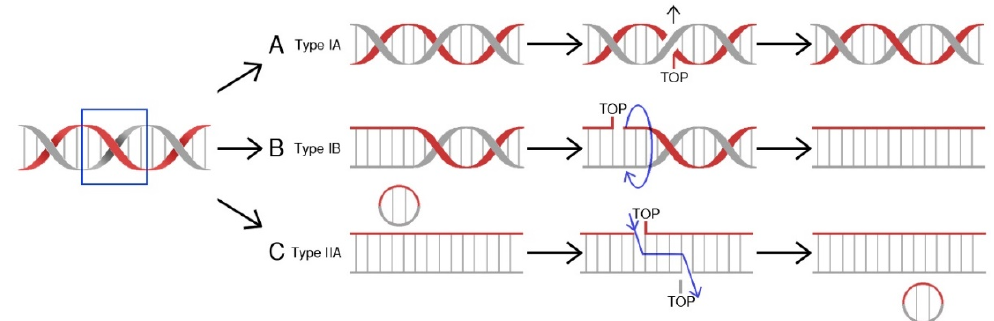
Figure 1. Mechanisms of action for human topoisomerases. ( A ) Topoisomerase IA binds to DNA at a particular binding site, and then claves one strand, forming a transient 5 ′‐ phosphotyrosyl bond. The other DNA strand is transferred through the resultant break, allowing DNA to relax. Religation ends the process. ( B ) Toposiomerase IB works in a controlled rotation mechanism and in contrast to type IA enzymes forms a 3 ′‐ phosphotyrosyl bond with a DNA molecule. Both type I (A&B) topoisomerases do not require ATP hydrolysis as a source of energy. ( C ) Topoisomerase II binds to both ends of the DNA molecule, forms a double ‐ strand break, and passes a segment of dsDNA through. This reaction is ATP ‐ dependent [19].